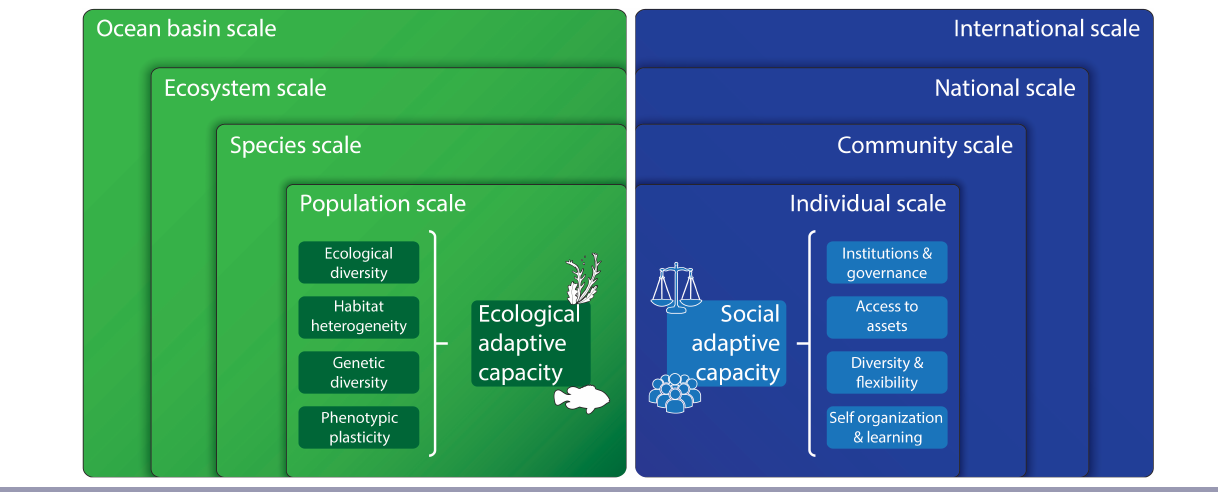
Fig. 2. Example measures of adaptive capacity in ecological or social systems across spatial scales. Measures are examples only and are not meant to be prescriptive or specific to a given scale as shown